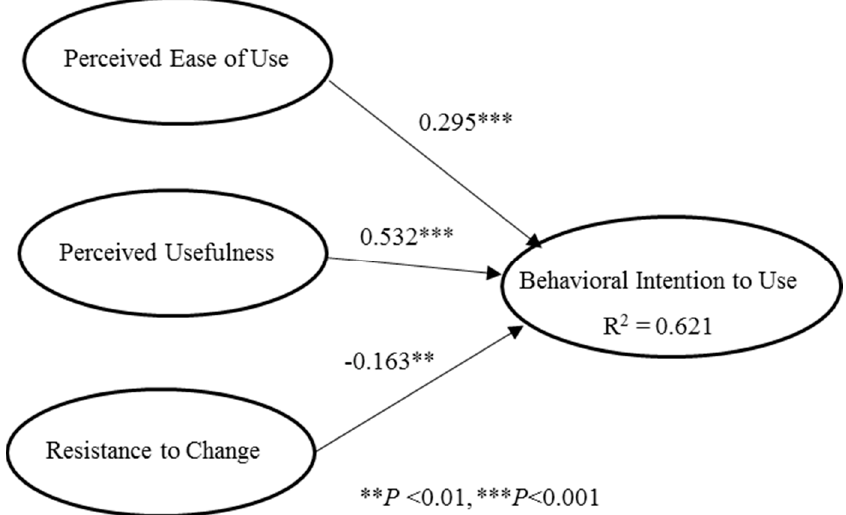
Figure 8. Partial least squares (PLS) path analysis results. (Note: values on the lines denote path coefficients of the causal relationships).